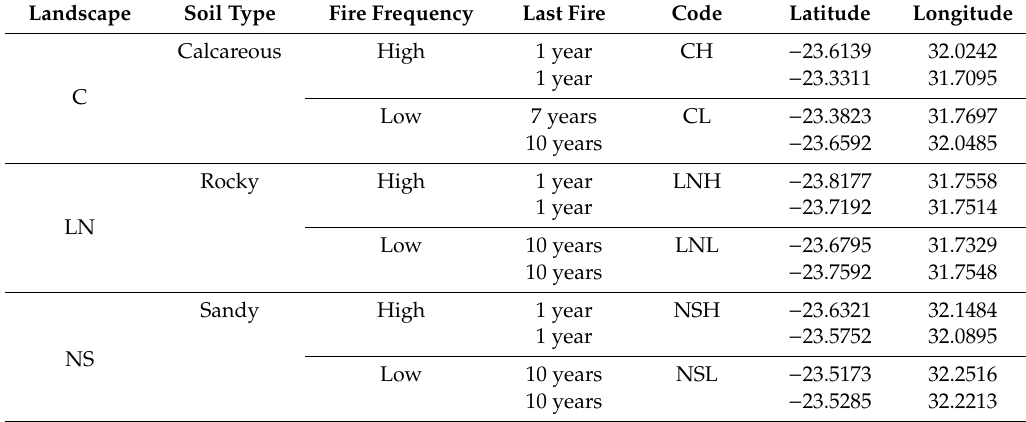
Table 1. List of sampling sites in the three di ff erent landscapes studied, soil types, regimes of fire frequency (high vs. low), sample codes, and geographical coordinates. C: Calcrete; LN: Lebombo North; NS: Nwambia Sandveld. The letter H following a landscape code indicates high fire frequency, while L indicates low fire frequency